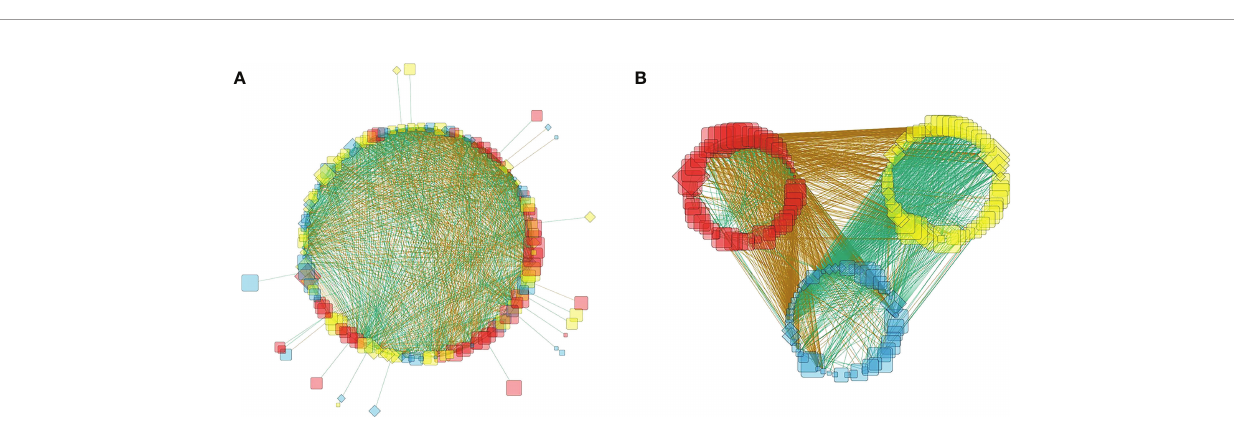
FIGURE 6 | Network analysis of bacteria together with archaea on the family level in the form of (A) circled layout and (B) grouped layout (B) . Every node represents a family of either bacteria (diamond) or archaea (round rectangle). The node size is proportional to its OTU readings. Nodes are marked as red, yellow and blue, which means the winner, loser and centrist in this work. Brown edges (lines between nodes) means the connected two nodes are negatively related to each other and cyan edges means the two nodes are positively related. Photo by Z-Y Zhu.